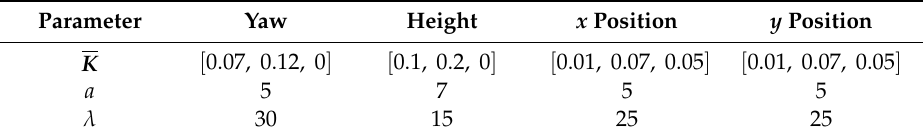
Table 1. The values of parameters of the HODFC.